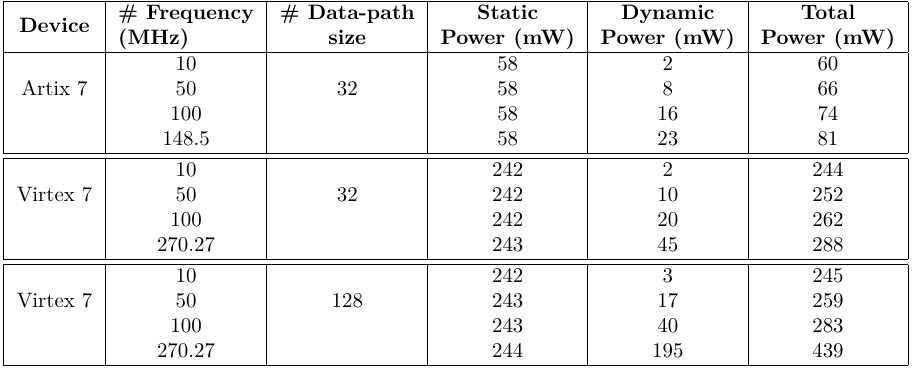
Table 10: Power consumption of the two proposed architectures for ESTATE _ TweAES in